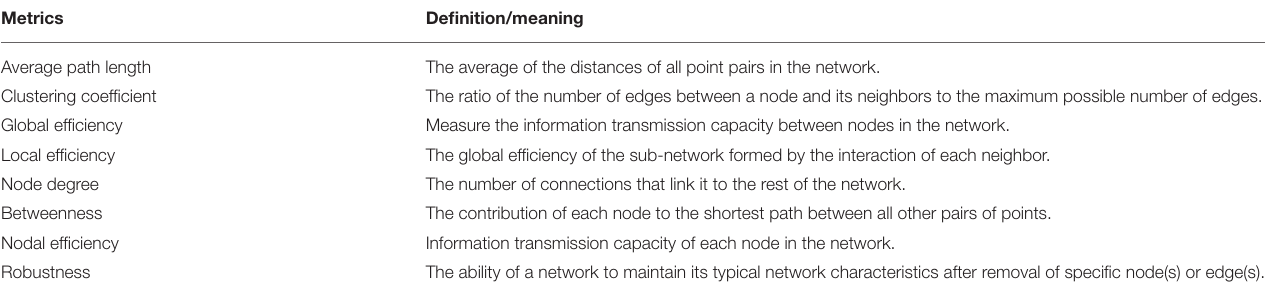
TABLE 2 | Main network metrics of graph